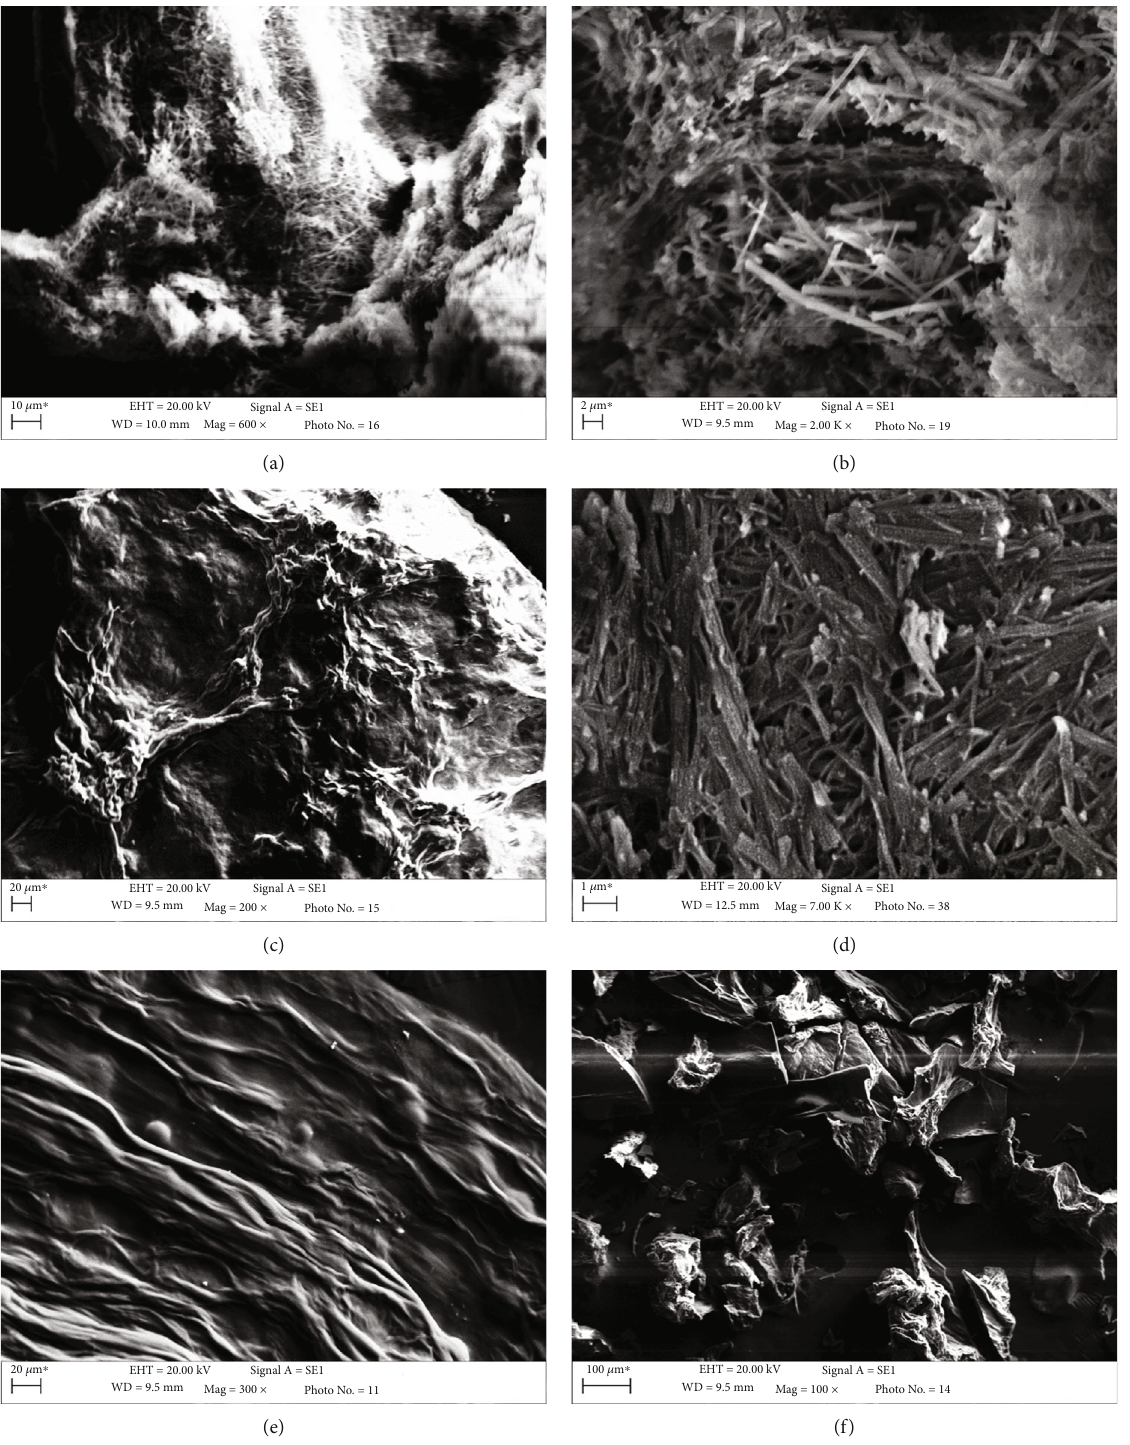
Figure 14: (a) 600-fold SEM diagram of DMTCP (ethyl ether), (b) 1.5K SEM diagram of DMTCP (ethyl ether), (c) DMTCP (CCl times SEM, (d) DMTCP (CCl